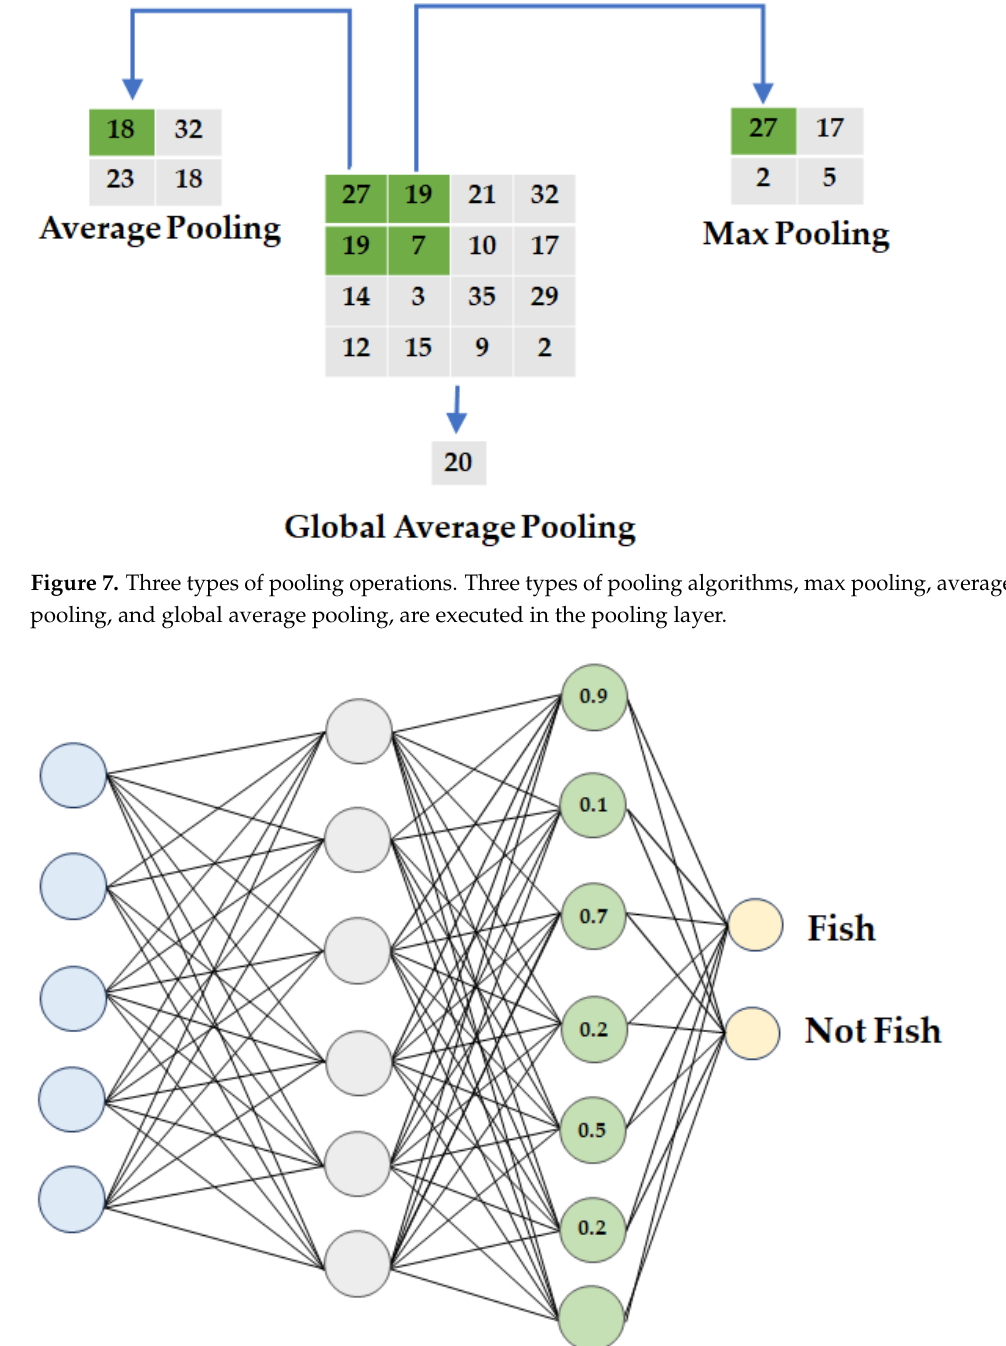
Figure 8. Example of a fully connected layer. Each neuron of the fully connected layer is connected to all the neurons of the previous layer. Similar to a conventional multilayer perceptron neural network, the fully connected layer is used as a classifier.